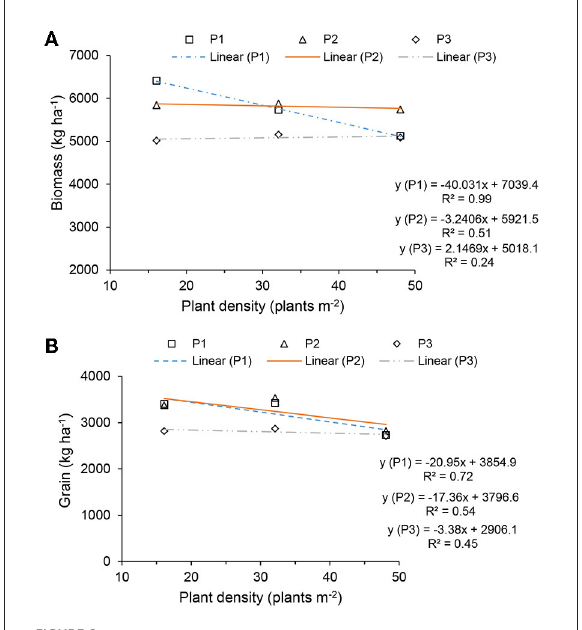
FIGURE6 Maize biomass (A) and grain yield (kg ha − 1 ) (B) as a function of plant density per area (P1, simultaneous sunn hemp and maize planting; P2, sunn hemp planted at the V15 maize growth stage; P3, sunn hemp planted at R1 maize growth